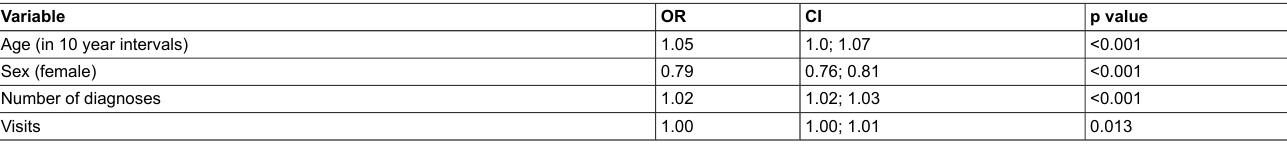
Table 3: Logistic regression – General Consent status: declined vs. consented.